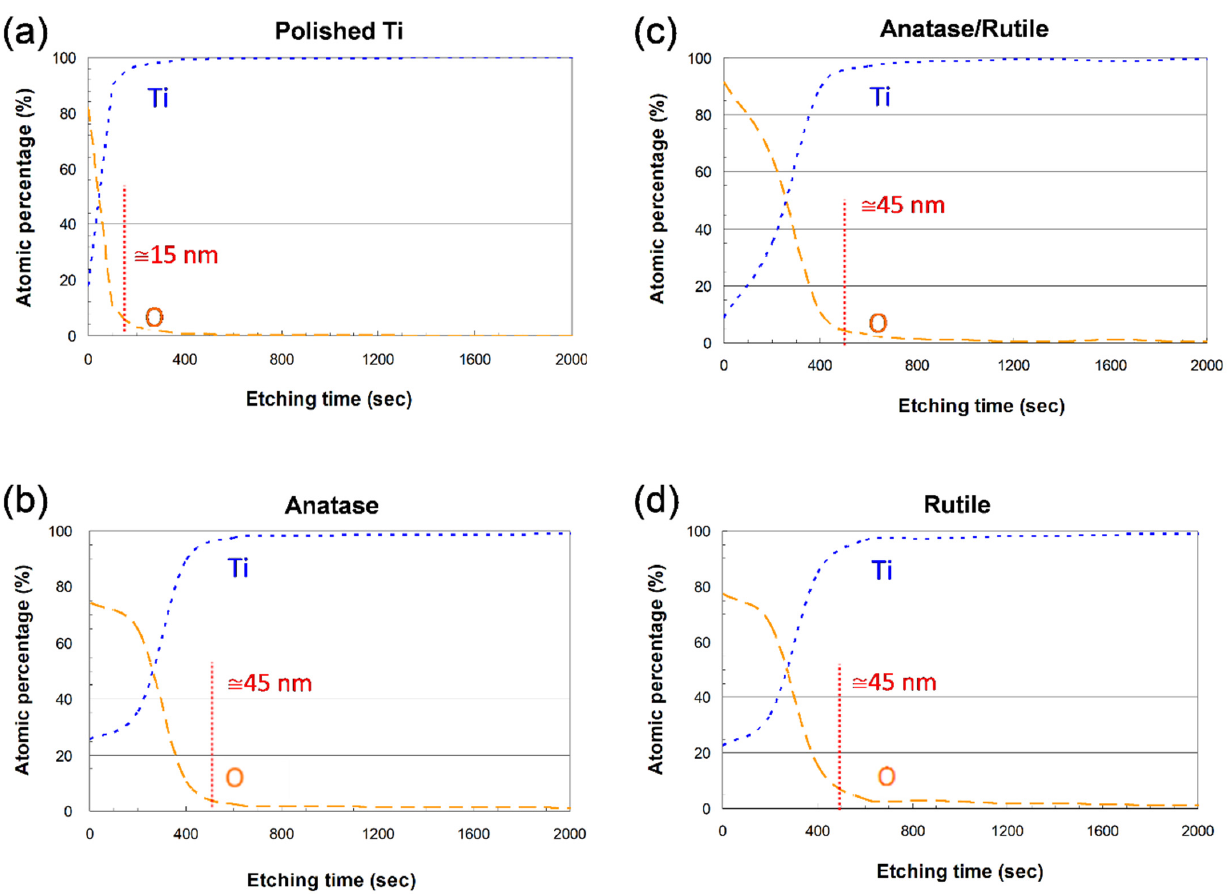
Figure 2. XPS depth profile analysis, in terms of Ti and O elements, of TiO 2 thickness on different Ti specimens. The thickness of the oxide layer on surface-modified Ti specimens was roughly 45 nm, approximately 3 times than that of unmodified polished Ti specimens.